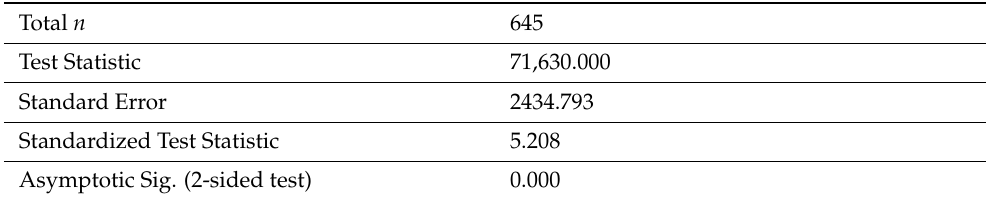
Table 9. Urbanization degree independent-samples Jonckheere–Terpstra test for ordered alternatives